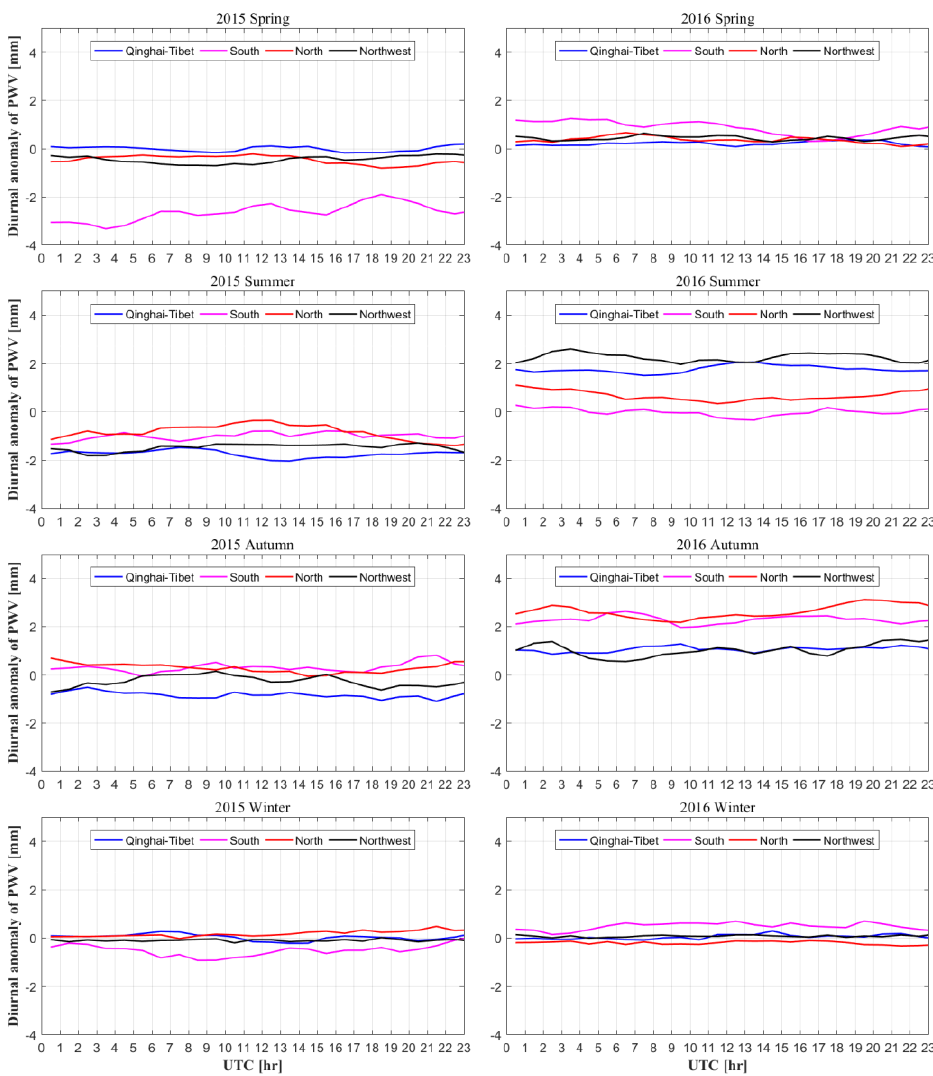
Figure 11. Hourly diurnal anomalies of PWV time series in the four regions of China in different seasons during the period 2015–2016.